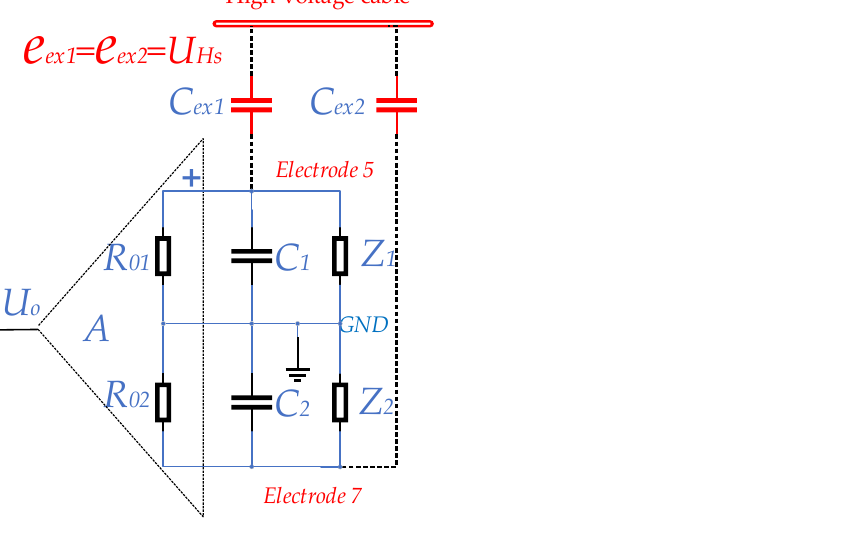
Figure 10. Equivalent Circuit of Coupling between High-voltage Cable and Electrode Loop through Distributed Capacitance.